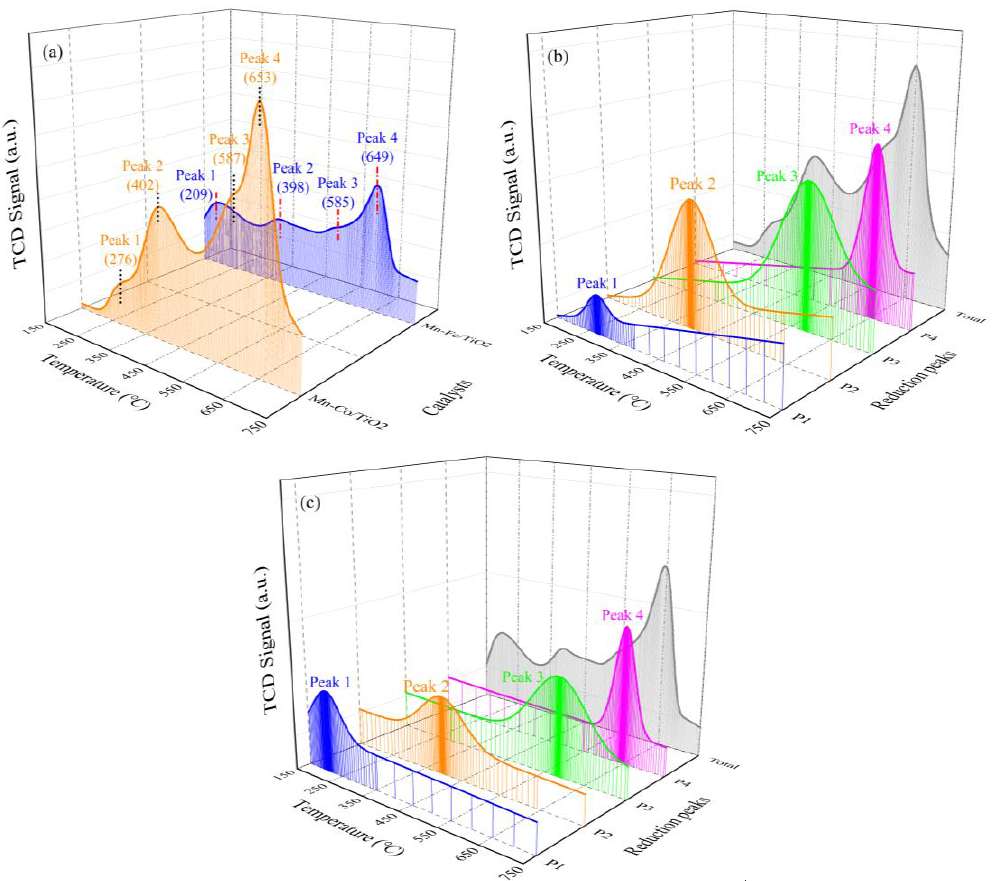
. Figure 5. NH 3 -TPD profiles of Mn − Co/TiO 2 and Mn − Fe/TiO 2 nanocatalysts: ( a ) Total NH 3 -TPD Figure 5. NH 3 -TPD profiles of Mn−Co/TiO 2 and Mn−Fe/TiO 2 nanocatalysts: ( a ) Total NH 3 -TPD curves; curves; ( b ) Multi-peaks Gaussian fitting for Mn − Co/TiO 2 nanocatalyst; ( c ) Multi-peaks Gaussian ( b ) Multi-peaks Gaussian fitting for Mn−Co/TiO 2 nanocatalyst; ( c ) Multi-peaks Gaussian fitting for fitting for Mn − Fe/TiO 2 Mn−Fe/TiO 2 nanocatalyst. Table 3. Quantitative analysis of NH 3 -TPD profiles.